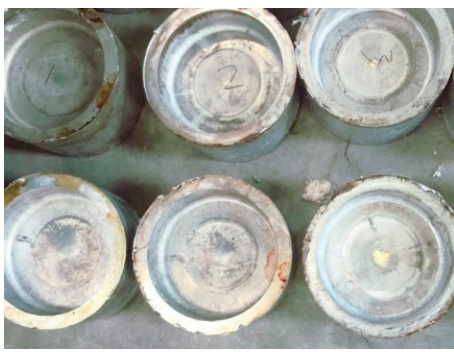
Figure 5. Scale-reduced parts of brake hub formed by rheological die forging.